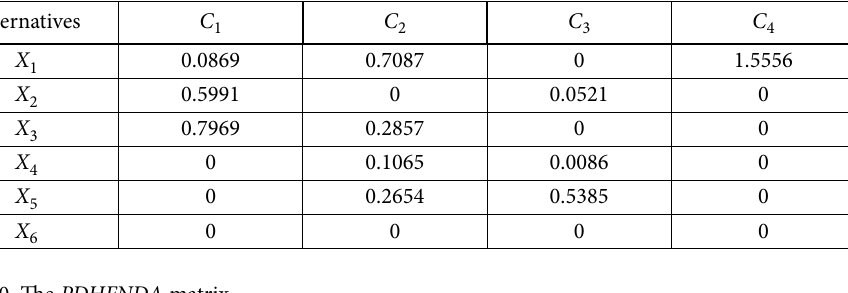
Table 10. The PDHFNDA matrix Alternatives